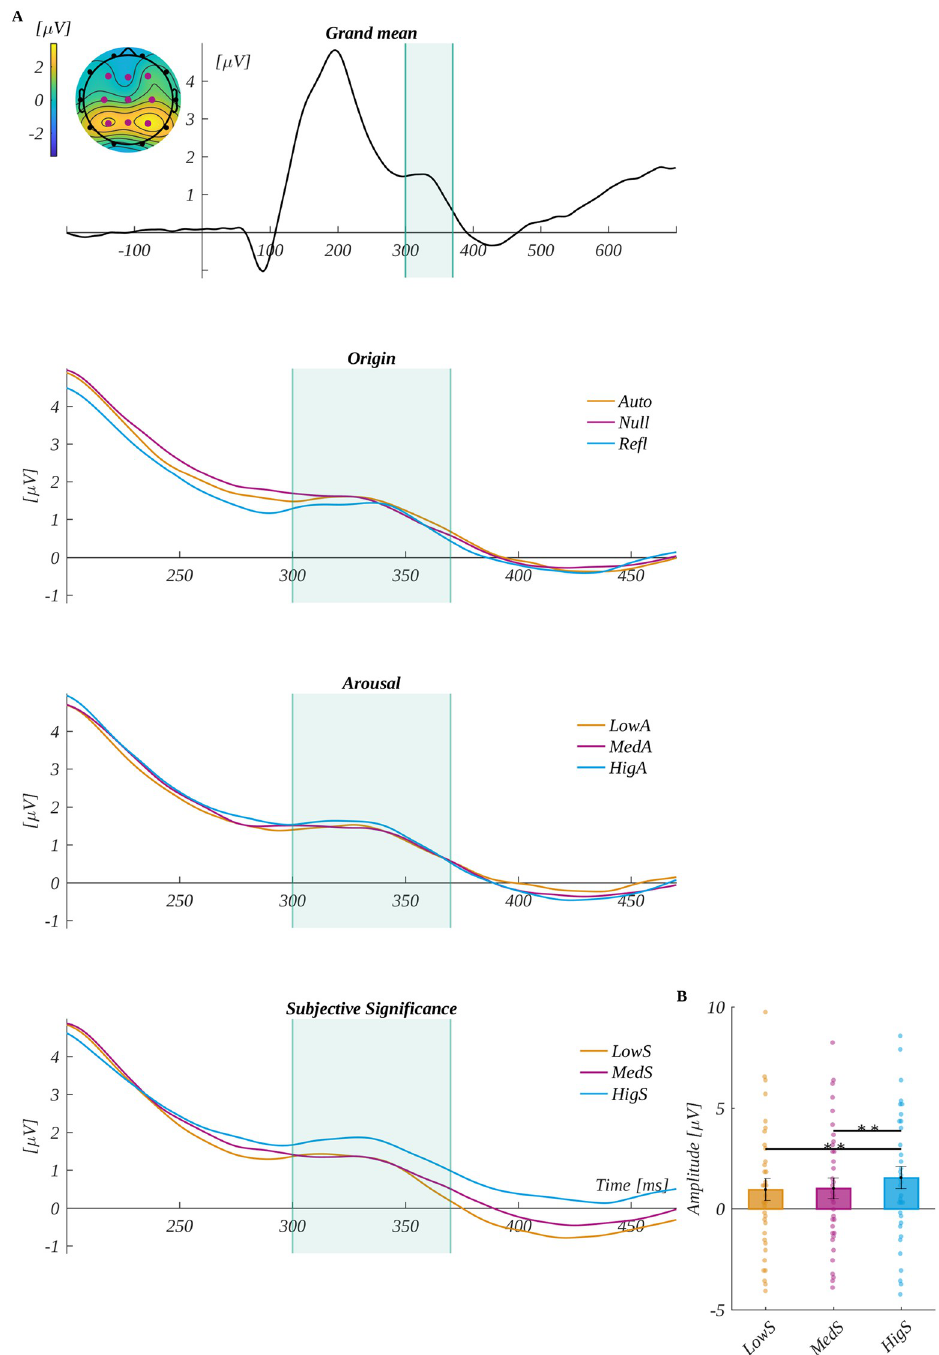
Fig 5. The P300 component results. The upper plot A is the grand average across electrodes from ROI P300. The marked time-interval was selected for the P300 analysis. The insert shows the topography of the mean potential from this period with the electrodes forming the ROI P300 marked with pink dots. The three bottom plots are the time courses of ERP averaged across electrodes from ROI P300 for each level of origin, arousal and subjective significance. B Main effect for subjective significance. The bars represent the mean value, error bars SEM, individual dots mark the average amplitude of an individual subject in the given condition, the black horizontal lines indicate pairs of conditions with significantly different means ( � p < .05, �� p <